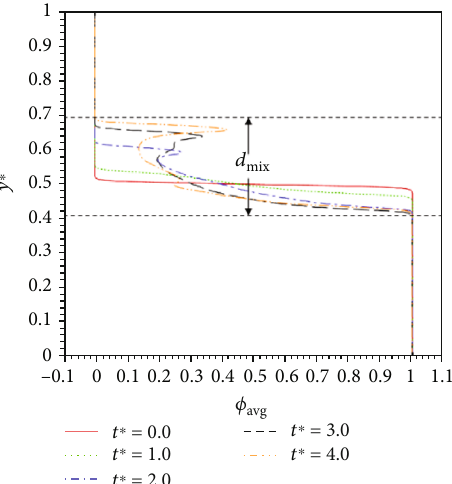
Figure 6: Snapshots of KHI for various density ratios and Reynolds numbers ( We = 400 , ν = ν , and t ∗ = 4 : 0 ). Figure A B